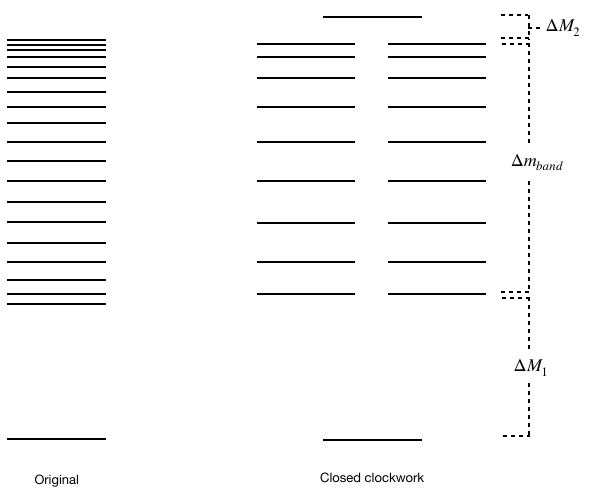
Figure 1 . Schematic depiction of the physical states in the closed clockwork theory (right) and in the original one-sided theory (left) for N = 20